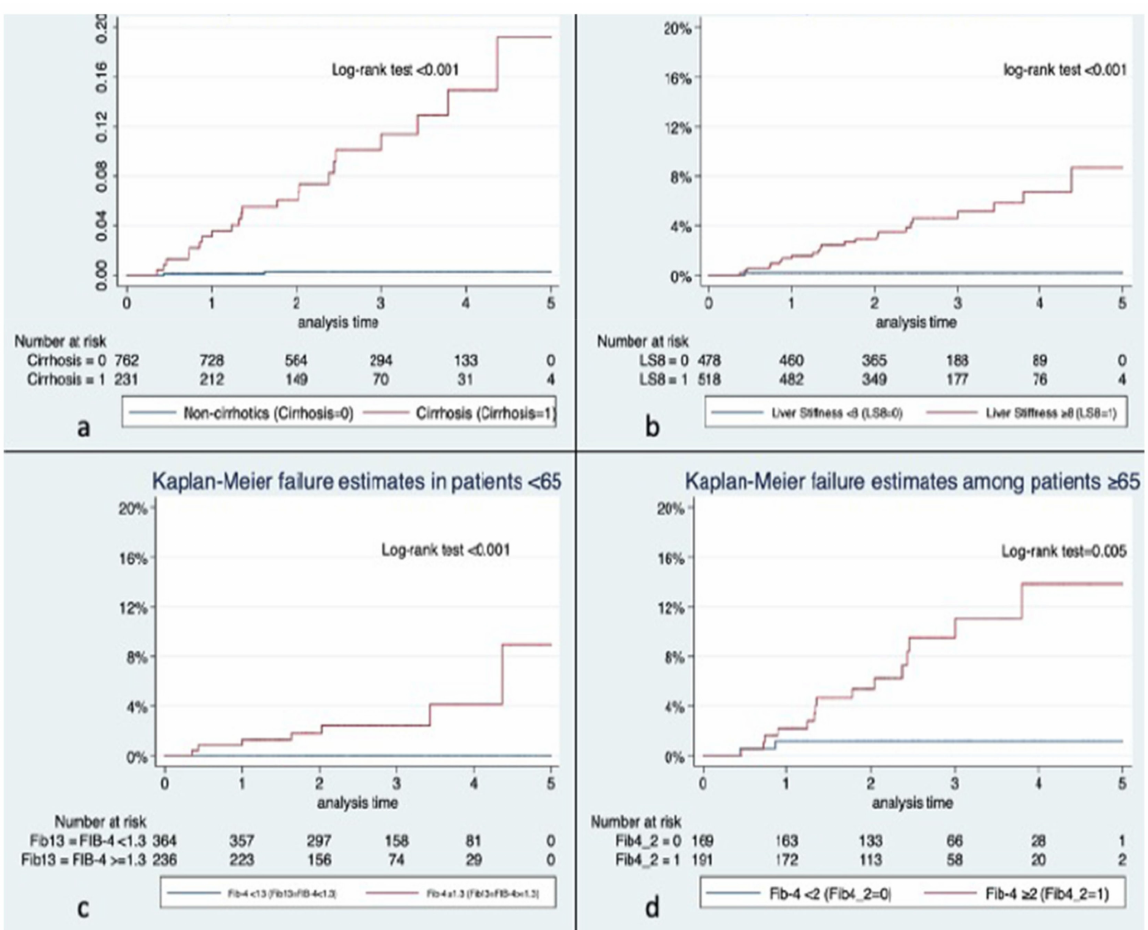
Figure 2. Kaplan–Meier survival curves for hepatocellular carcinoma incidence according to the presence of cirrhosis ( a ), liver stiffness measurement ( b ), and FIB-4 index adjusted to age ( c , d ). Amongst the 249 patients with available liver biopsy, the incidence of HCC was not significantly different between patients with and without steatosis (6/207 (2.9%) vs. 4/40 (10%); p = 0.06). Similarly, there were no significant differences in the incidence of HCC when comparing patients with and without significant lobular inflammation (3/51 (5.8%) vs. 6/192 (3.1%); p = 0.4). Furthermore, the incidence of HCC was not significantly different between patients with and without prominent ballooning (1/90 (1.1%) vs. 8/153 (5.2%); p = 0.1). In contrast, patients with biopsy-proven grade 3–4 fibrosis had a significantly higher incidence of HCC when compared to patients with lower grades of fibrosis (10/138 (7.25%) vs. 1/111 (0.9%); p = 0.02). Figure 3 shows the Kaplan–Meier curve (log-rank p =